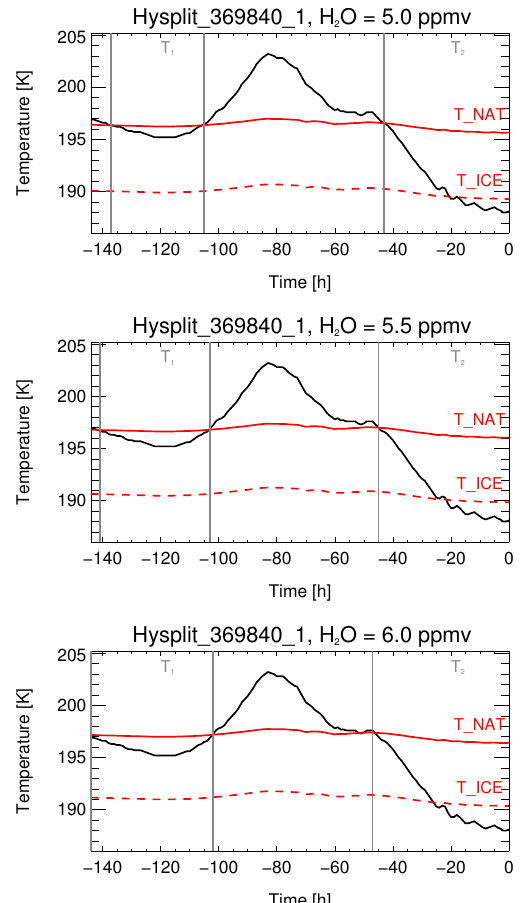
Figure 5. Temperature history of the back trajectory calculated with HYSPLIT based on the PSC measured with CALIPSO on 23 Jan- uary 2011 (back trajectory started at 18km at 20:00UTC). Top: for a typical H 2 O mixing ratio of 5ppmv in the polar lower strato- sphere, middle: for an H 2 O enhancement of 0.5ppmv (5.5ppmv), bottom: for an H 2 O enhancement of 1ppmv (6ppmv). The NAT existence temperature T NAT and ice formation temperature T ice are given as solid and dashed lines, respectively. Temperatures drop be- low the NAT formation temperature at time periods t = − 135 to − 105h and t = − 45 to 0h. The temperature ranges during these time periods are denoted by T 1 and T 2 , respectively (grey solid lines).